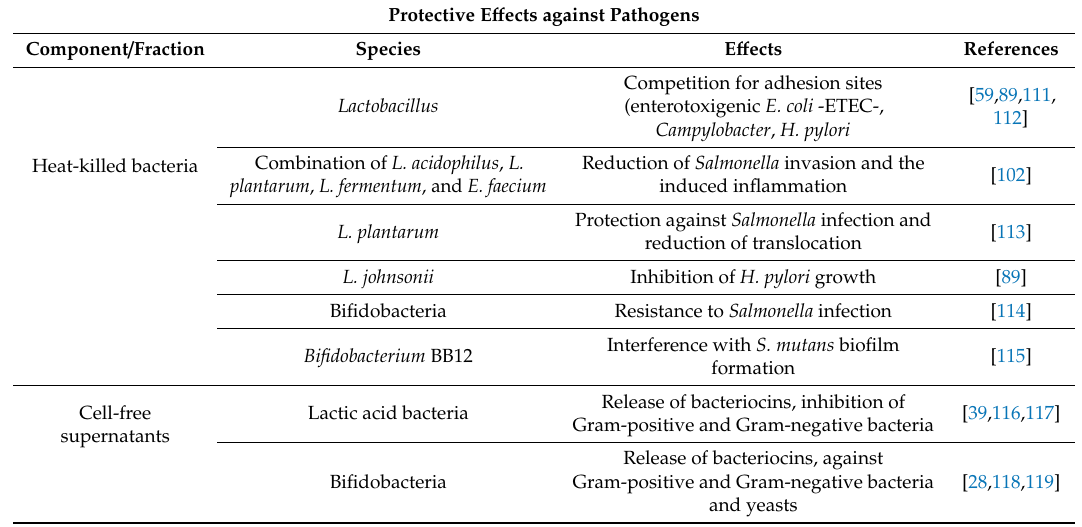
Table 3. Protection against pathogens of heat-killed probiotic bacteria and cell-free